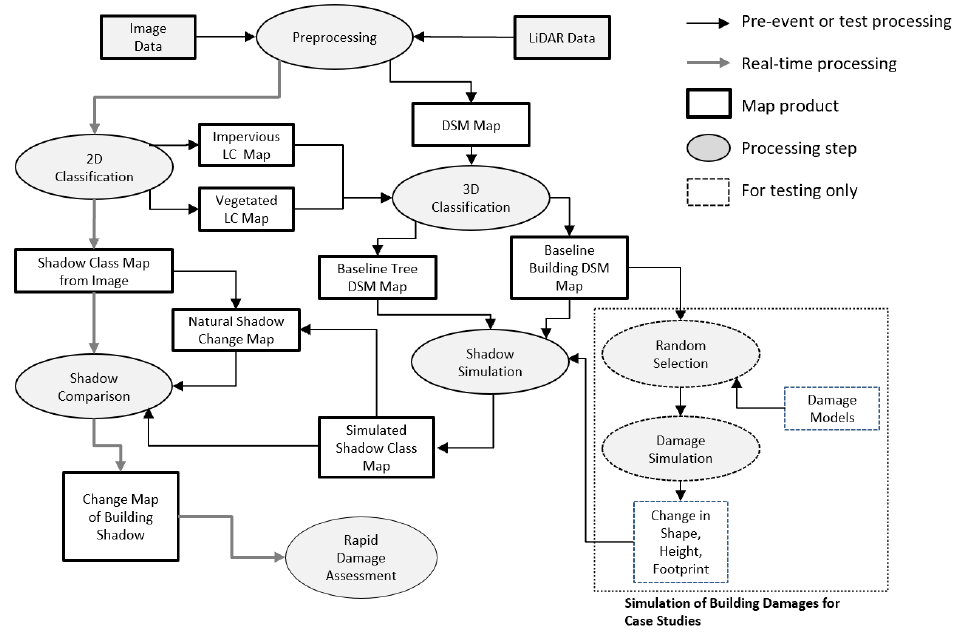
Figure 2. Outline of the framework for rapid damaged building detection. In the figure, DSM: digital surface model; LiDAR: light detection and ranging; LC: land cover.